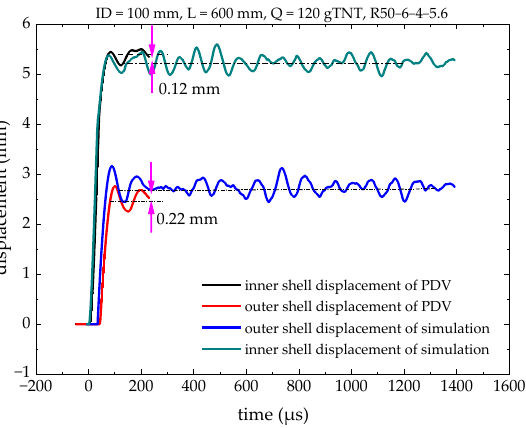
Figure 16. Displacement comparison of PDV measurement and simulation. The velocity curves of the outer cylinder obtained by numerical simulation and PDV measurement in experiment No. 3, using double-layer steel cylindrical shells of 100 mm inner diameter, 8 mm thickness of the inner cylindrical shell, 3.8 mm thickness of the outer cylindrical shell and 4 mm gap between the inner shell and the outer shell, are shown in Figure 17. Figure 18 shows an enlarged figure of the front part of the above two curves.